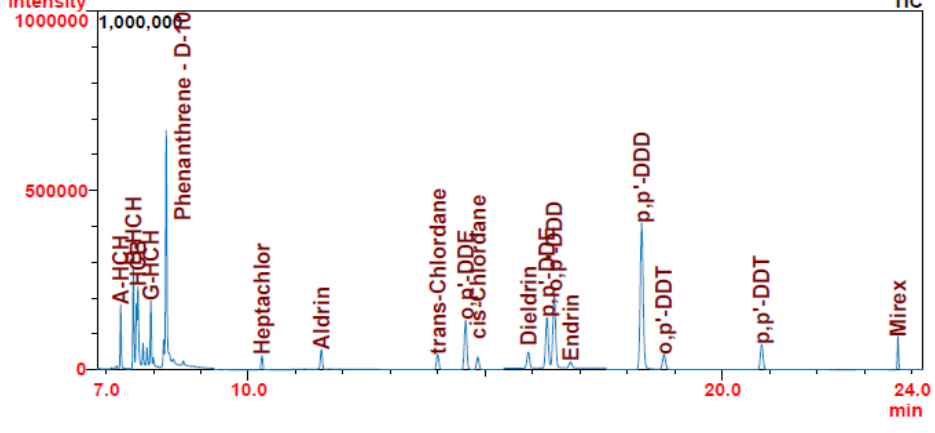
Figure 1. Chromatogram of Pesticide standards.